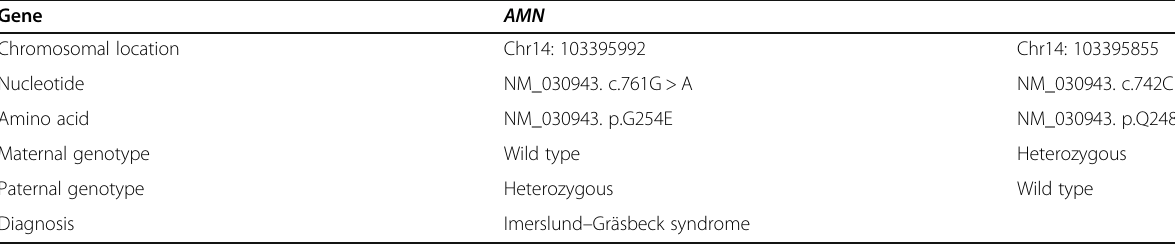
Table 2 Genetic testing of Case 2 and his